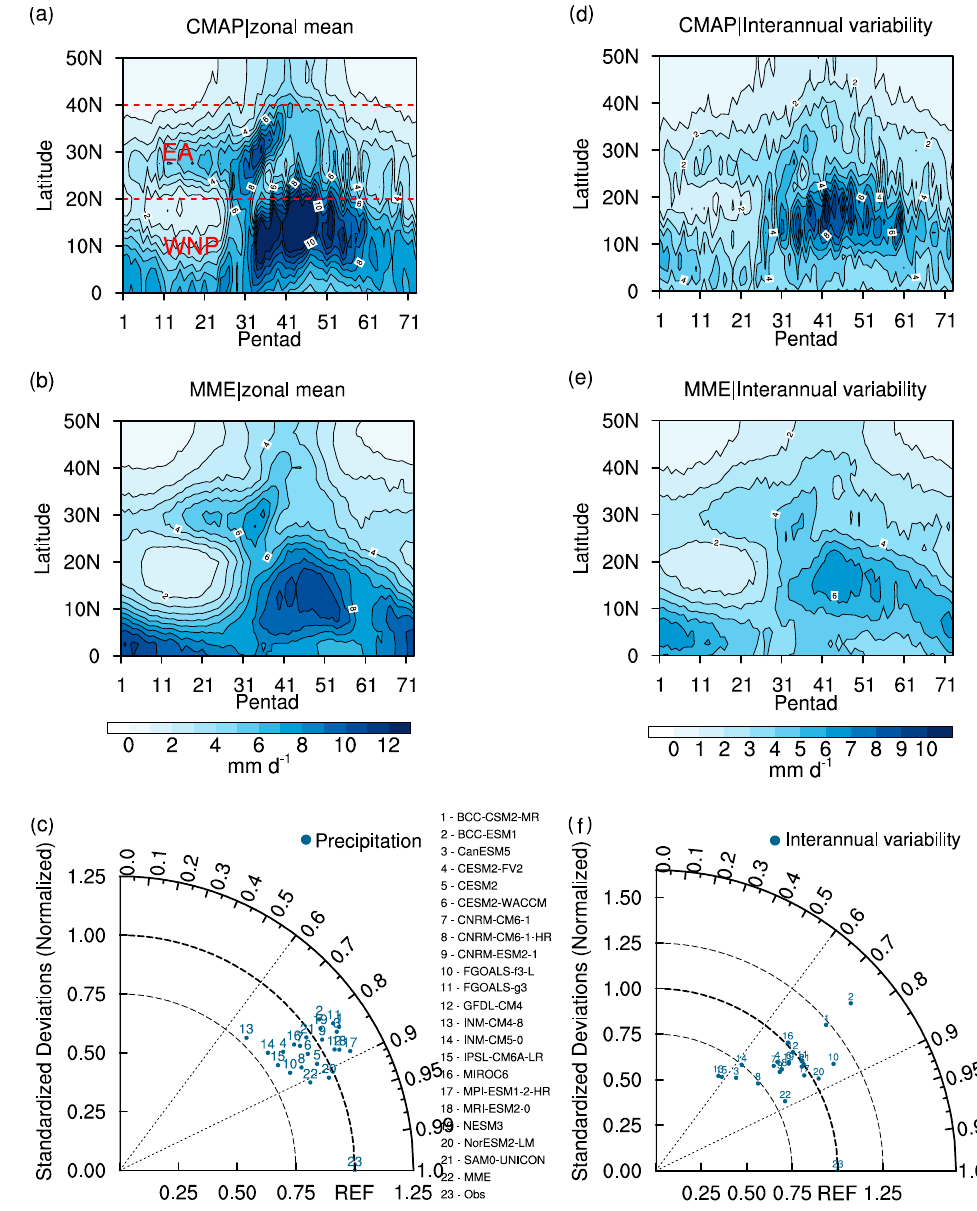
Figure 1. Climatological and interannual variability of the seasonal migration of East Asian zonal mean (1979–2014, 115°–135° E) rainfall. Climate mean seasonal march for ( a ) Climate Precipitation Center Merged Analysis of Precipitation (CMAP), ( b ) multi-model ensemble (MME) (unit: mm day –1 ). ( c ) Taylor diagram exhibits a statistical comparison of the spatial structure of ( a ) and ( b ). The metrics encompass the standardized deviation ratios (SDR, referring to the ratio of model’s pattern standard deviation against the observed pattern standard deviation, vertical axis), root-mean-square-error (RMSE, distance to the REF), and the spatial pattern correlation coefficients (PCC, azimuthal axis) among the 21 CMIP6 models and MME mean comparing with the observation. ( d – f ) are the same as ( a – c ), but for the year-to-year standard deviations of the zonal mean rainfall.